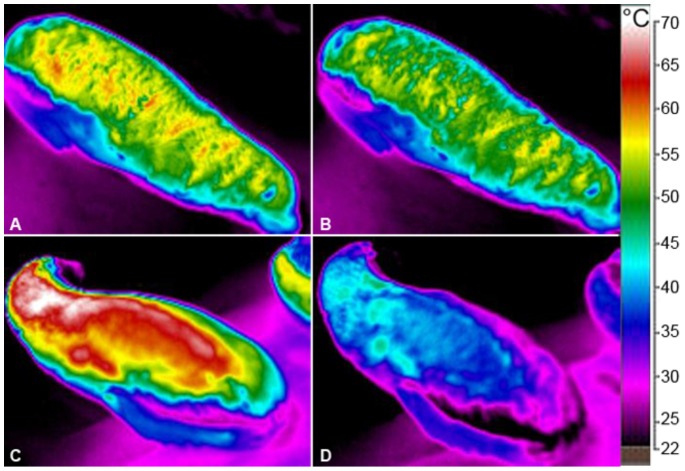
Reduction of Tsurface on hauled out pups by wind forced convection.Pups hauling out under solar radiation with sudden appearance of a light breeze of wind force 1–2 (Beaufort), corresponding to 0.2–3.3 m/s. (A) Pup with Tmax = 61.2°C on the surface, Tair = 17.3°C. (B) Decreased Tsurface after light breeze for 5 s to Tmax = 58.8°C (3.9%). (C) Pup with Tmax = 72.3°C on the surface, Tair = 23.8°C. (D) After 42 s of light breeze Tsurface decreased to Tmax = 47.3°C (34.6%).